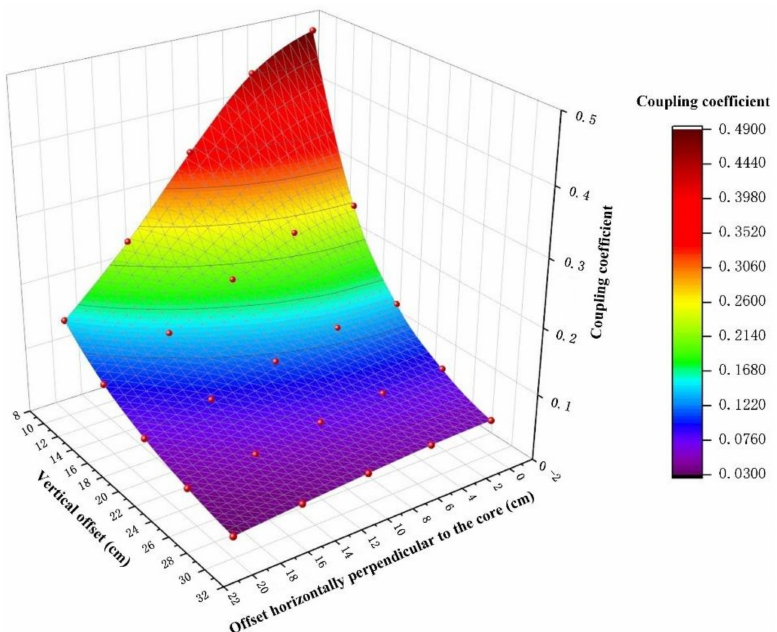
Figure 16. Relationship diagram between the horizontal misalignment and the coupling coefficient of a transformer with DD